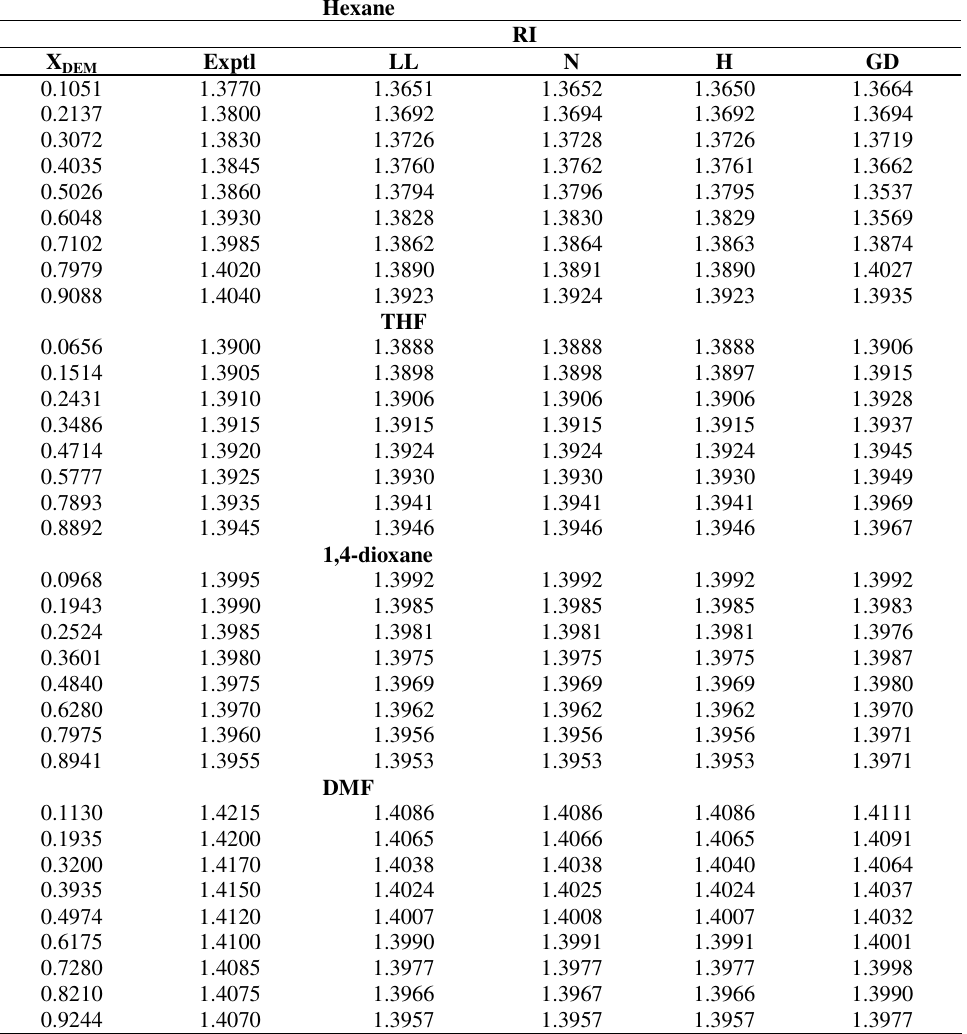
Table 2. Experimental and Theoretical values of refractive index of binary liquid systems